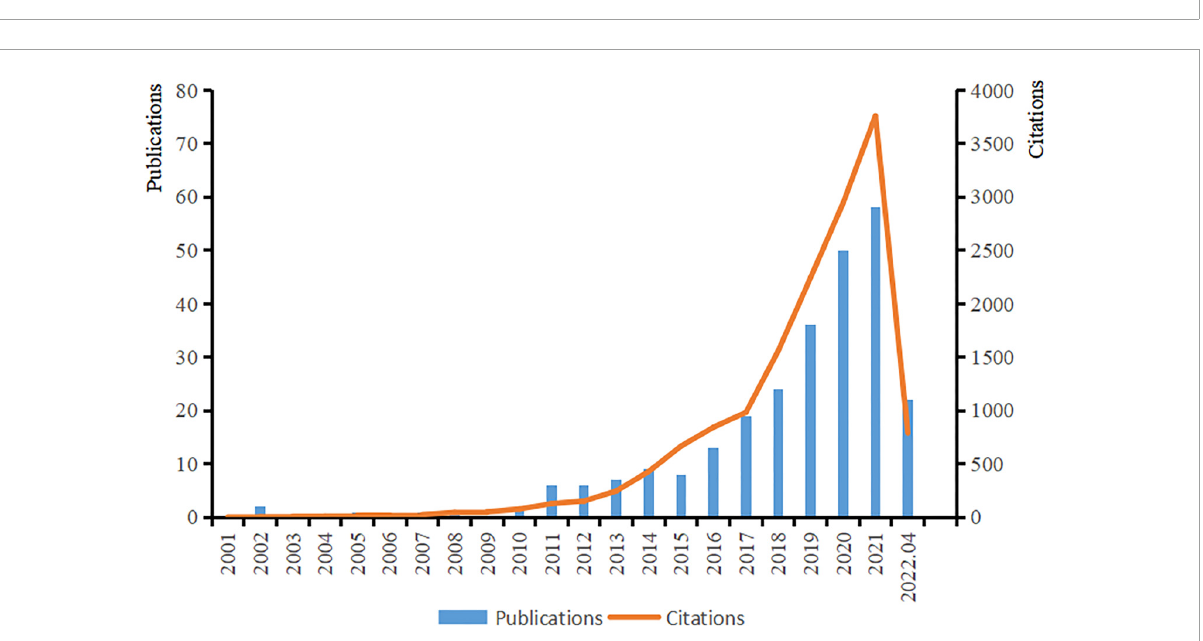
FIGURE2 Trends in publications and citations from January 1980 to April